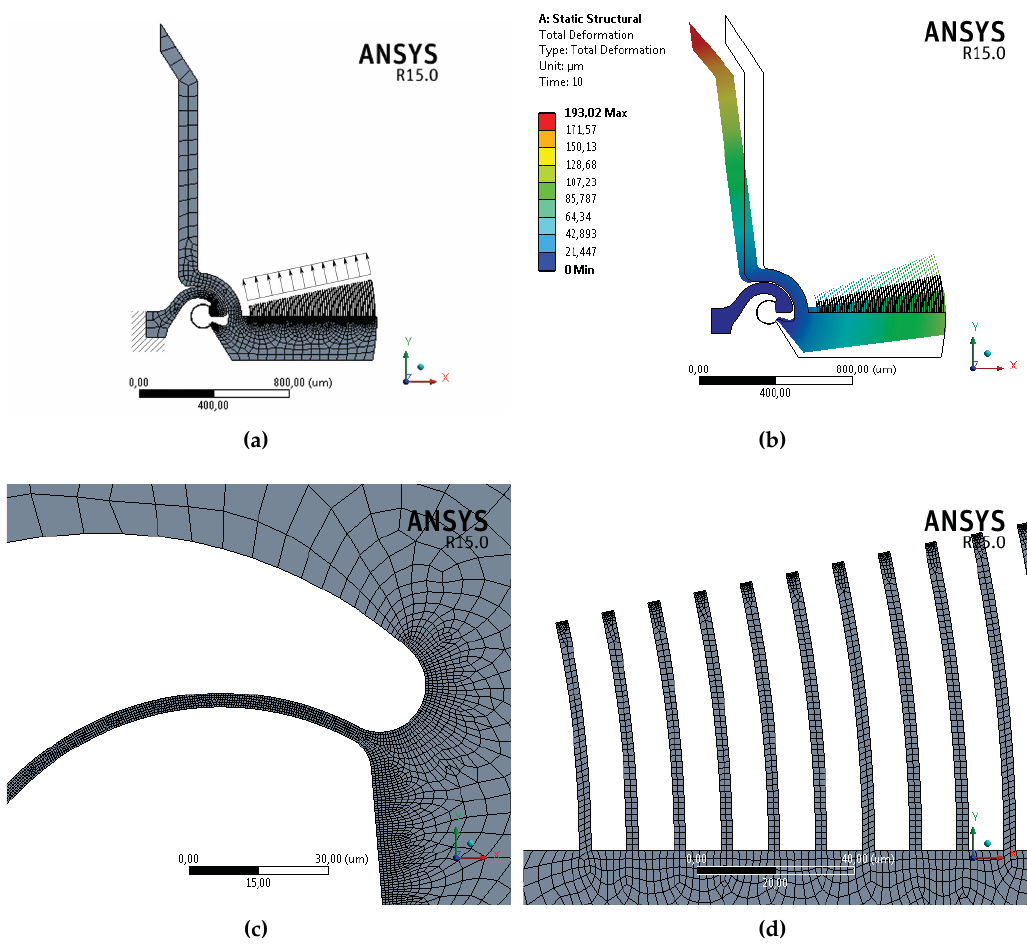
Figure 2. Finite element analysis: mesh and load conditions ( a ); total displacement corresponding to the applied voltage of 40 V ( b ); mesh refinement in the flexure ( c ) and in the fingers ( d